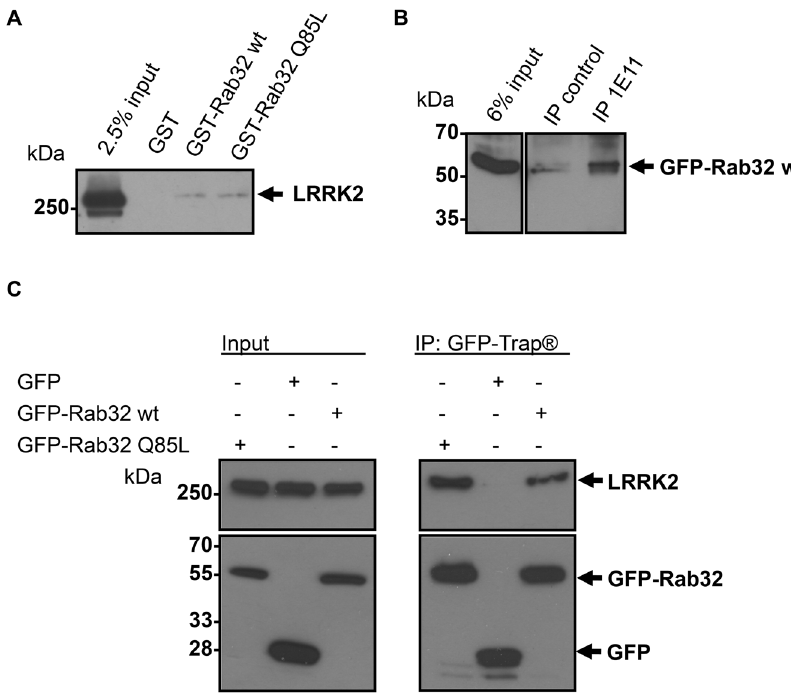
Figure 2. Binding of endogenous LRRK2 by the small GTPase Rab32. (A) GST-Rab32 wt, GST-Rab32 Q85L or GST as control was applied to glutathione agarose beads followed by incubation with NIH3T3 lysate overnight. Samples were analyzed by 6% SDS-PAGE and subsequent Western blot analysis to detect LRRK2. n $ 3 independent experiments. (B) Lysates from IHKE-1 cells stably expressing GFP-Rab32 wt were incubated overnight with an anti-LRRK2 antibody (1E11). IP control=no antibody was added. Co-precipitated GFP-Rab32 wt was detected using an anti-Rab32 antibody. n=3 independent experiments. (C) Lysates from IHKE-1 cells expressing GFP-Rab32 wt, GFP-Rab32 Q85L or GFP as control were subjected to immunoprecipitation by the GFP-Trap kit. Co-precipitated endogenous LRRK2 was detected using an anti LRRK2 antibody. n=2 independent experiments.